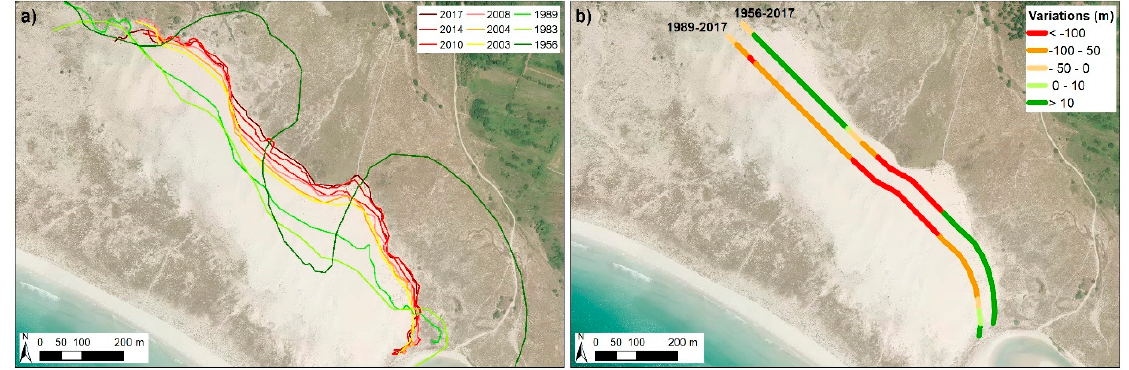
Figure 5. ( a ) represents the front dune line in each analyzed year and ( b ) shows the variations of these fronts between 1956 and 2017 and between 1989 and 2017. Positive values indicated an advance to seaward while negative values indicate a variation to landward.